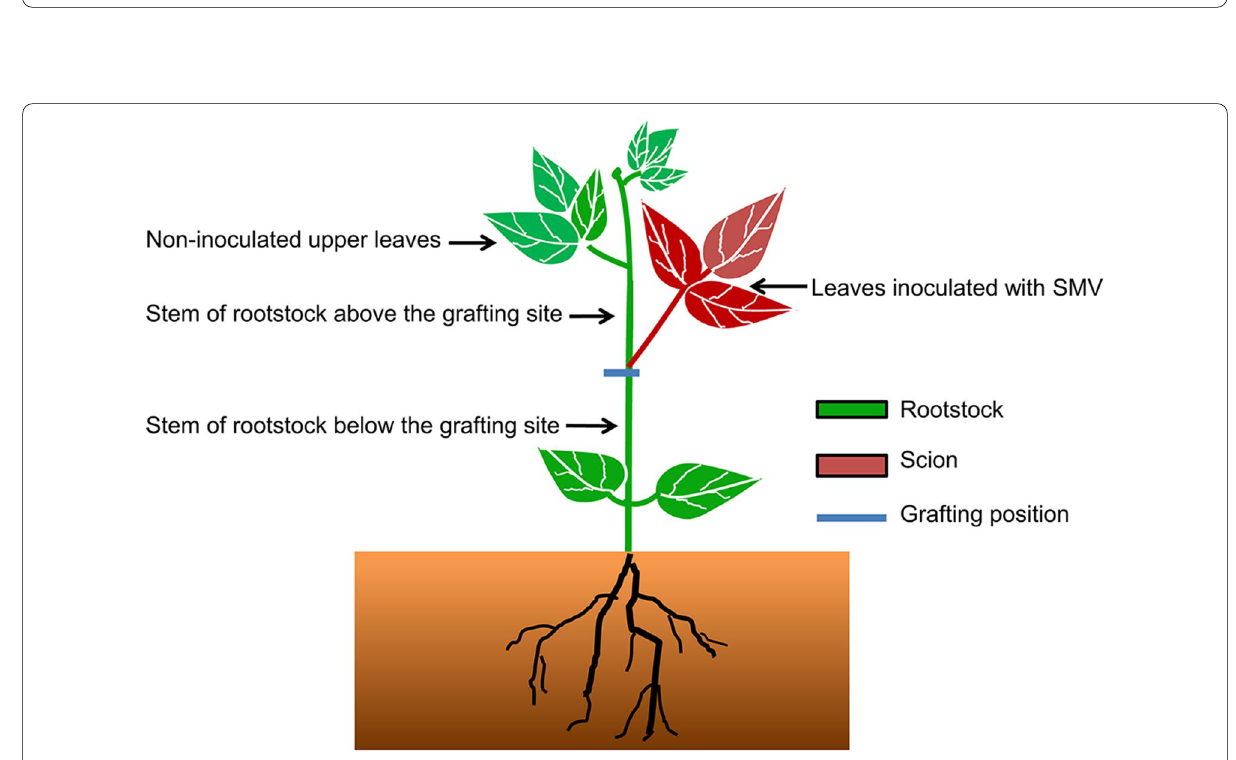
Fig. 3 Schematic diagram showing virus inoculation of different resistant genotypes after